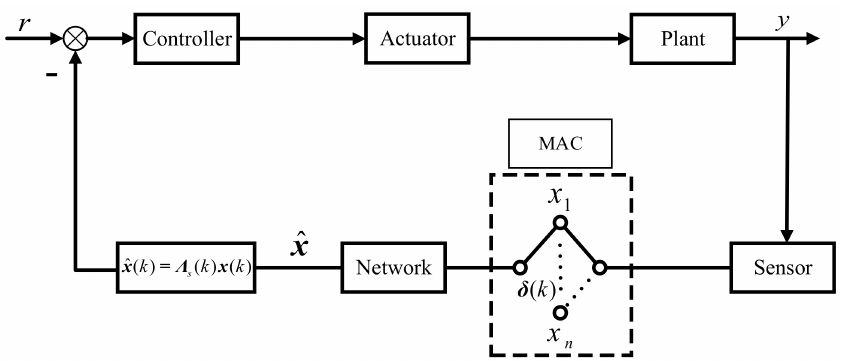
Figure 2. NCS with the MAC but without the zero-order hold.